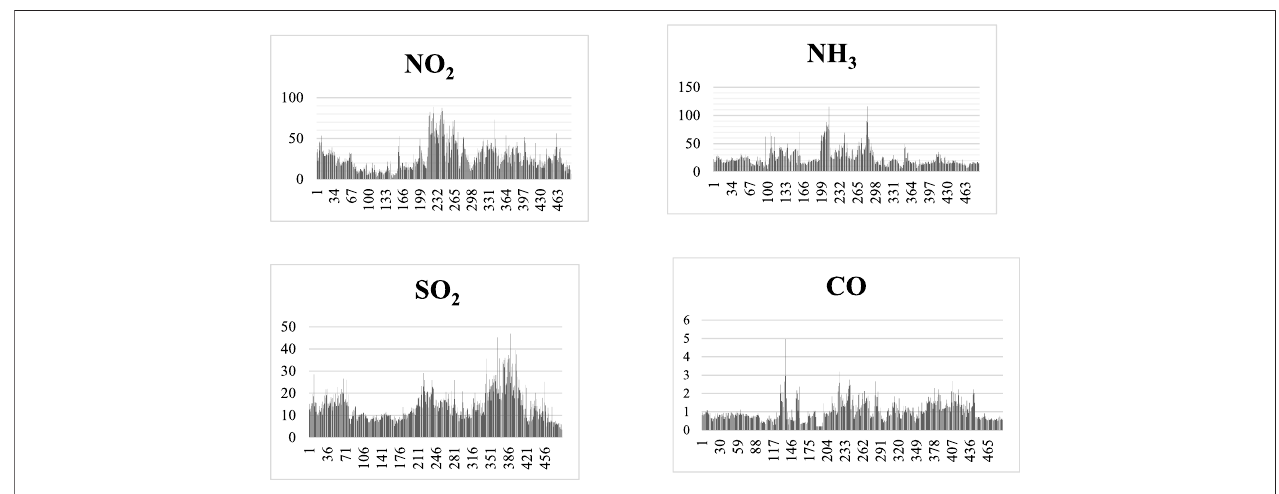
FIGURE 1 | Daily data series of greenhouse gases from March 3, 2020, to July 27,